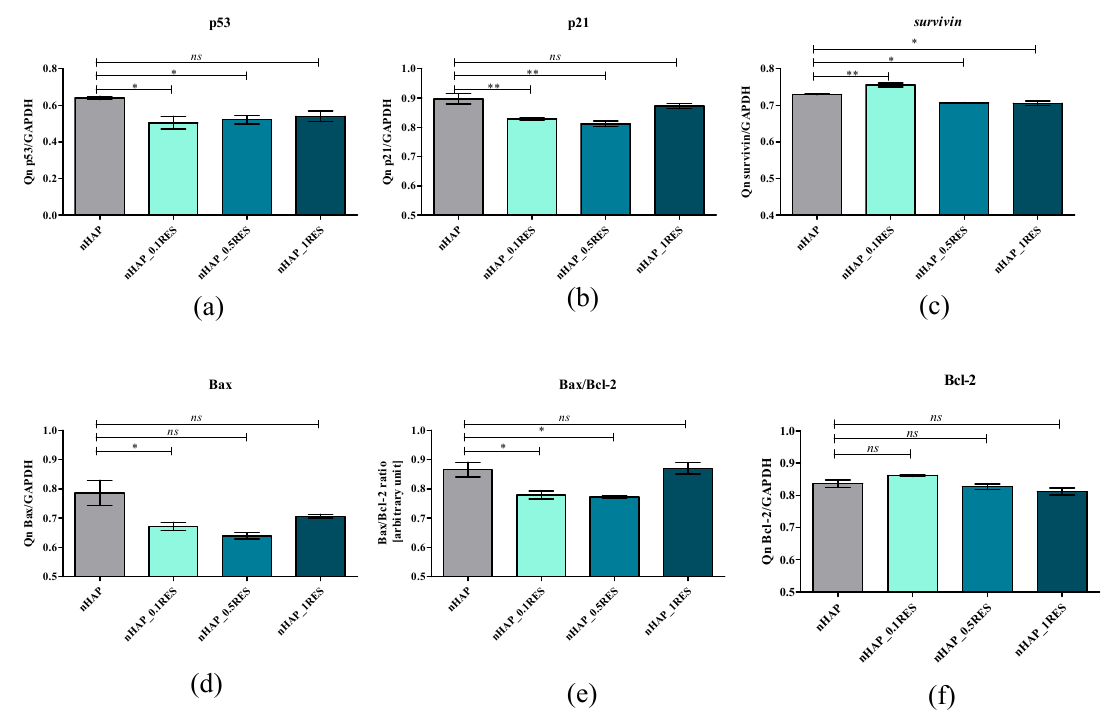
Figure 14. Relative expression of genes involved in the regulation of apoptosis p53 ( a ), p21 ( b ), survivin ( c ), Bax ( d ), and Bcl- ( e ) normalized to expression of GAPDH. The expression ratio of Bax and Bcl-2 in human ASCs ( f ). Statistically significant changes are indicated with asterisks, (*) p < 0.05 and (**) p < 0.01, while non-significant differences are marked as ns .